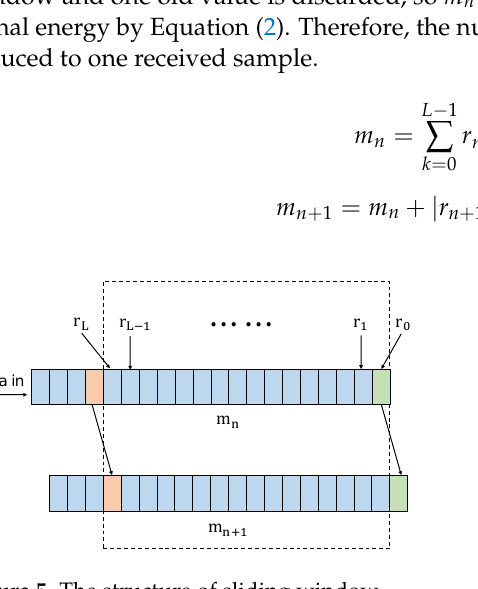
Figure 5. The structure of sliding